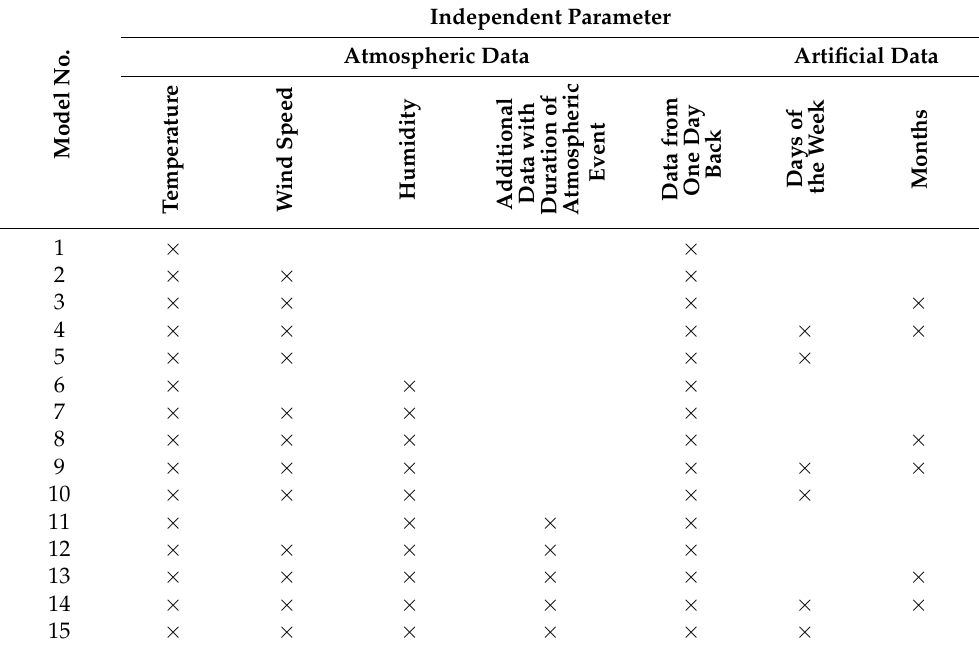
Table 2. Data ranges used to calculate the best model. Temperature: daily average, min/max, or at ground level with data from 1 day